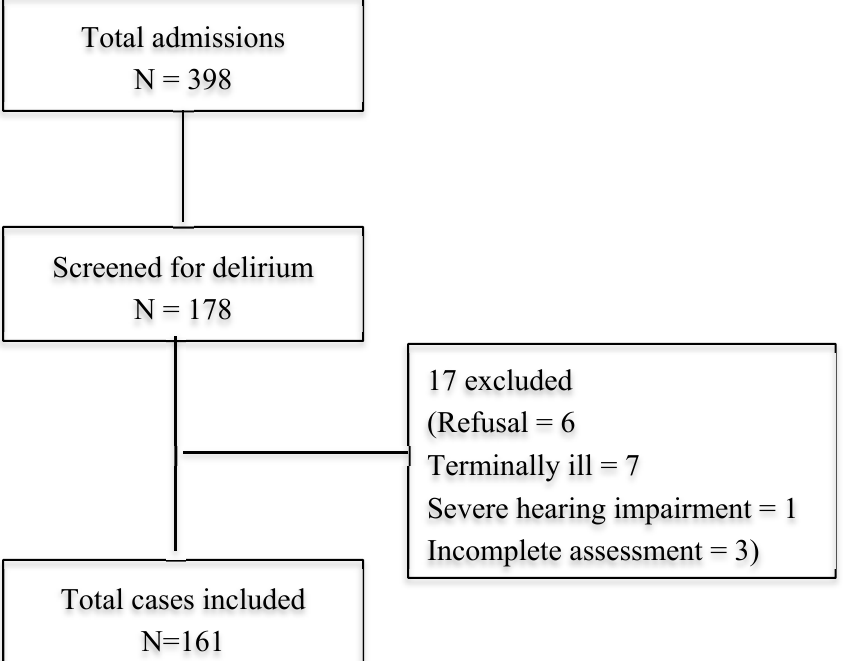
Figure 1. Flow Diagram of Study